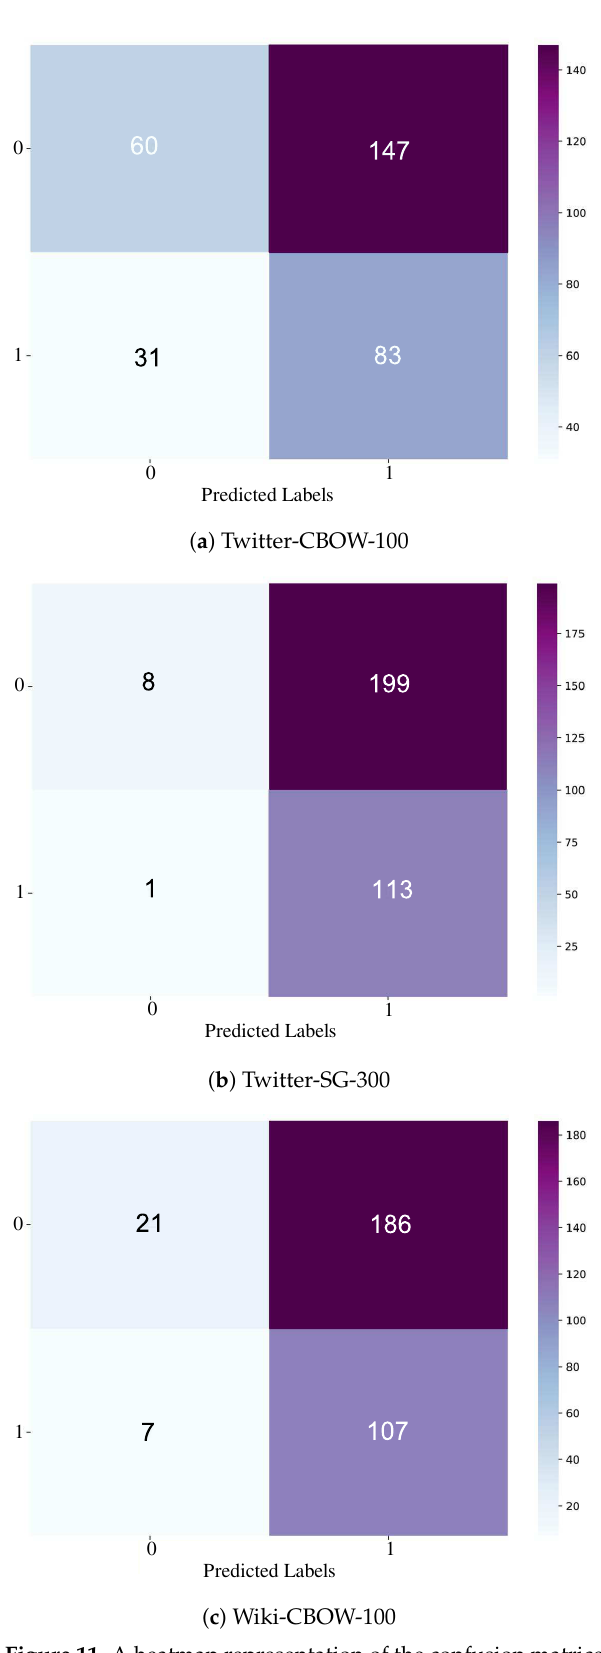
Figure 11. A heatmap representation of the confusion matrices of the best models from the transcript- based approach with different embedding